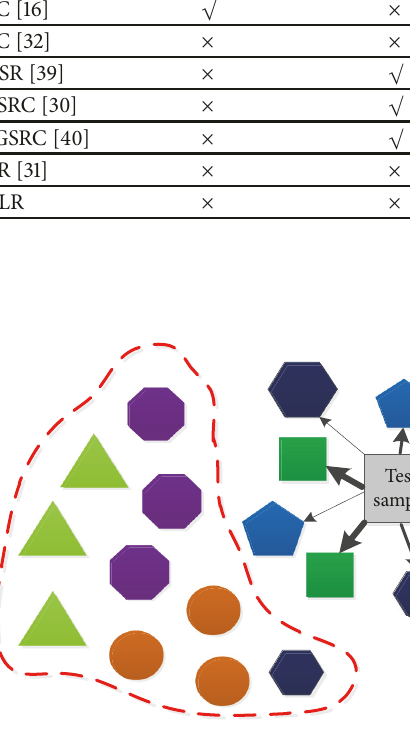
Figure 1: Overview of the proposed method. CoLR adopts a coarse- to-fine strategy to search for the most relevant training samples and classes with test sample. Nonneighbor training classes and samples are implicitly excluded by imposing bigger punishment (in red dotted line). This way, the test sample is guided to be represented by its nearby training classes and samples for a more discriminative classification-oriented local representation. This is the discriminability origin of